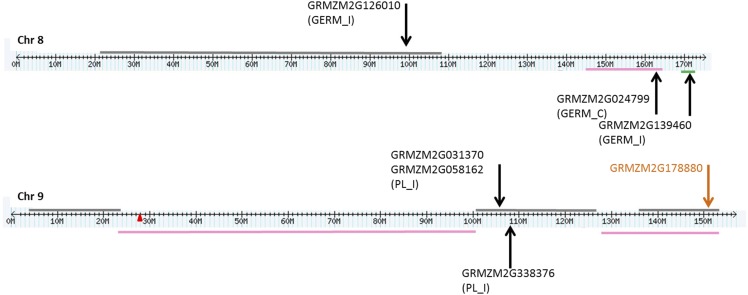
Localization of QTL and genes containing or adjacent to SNPs identified by GWAS on chromosomes 8 and 9. Genes associated with different traits (PL_C; PL_I; PW_C; PW_I; GERM_C; GERM_I) from this study are indicated by the black arrow. Candidate genes from Zila et al. (2013) are indicated by the orange arrow. Horizontal lines of different colors represent different QTL intervals for resistance to Fusarium and fumonisin accumulation identified by previous reports: pink and gray (Fusarium ear rot and fumonisins from Lanubile et al. 2014b and Maschietto et al. 2017, respectively); green (Fusarium seed rot from Ju et al. 2017); blue (Fusarium seedling rot, plant length and weight from Septiani et al. 2019). The centromere is indicated by a red label on the chromosome.